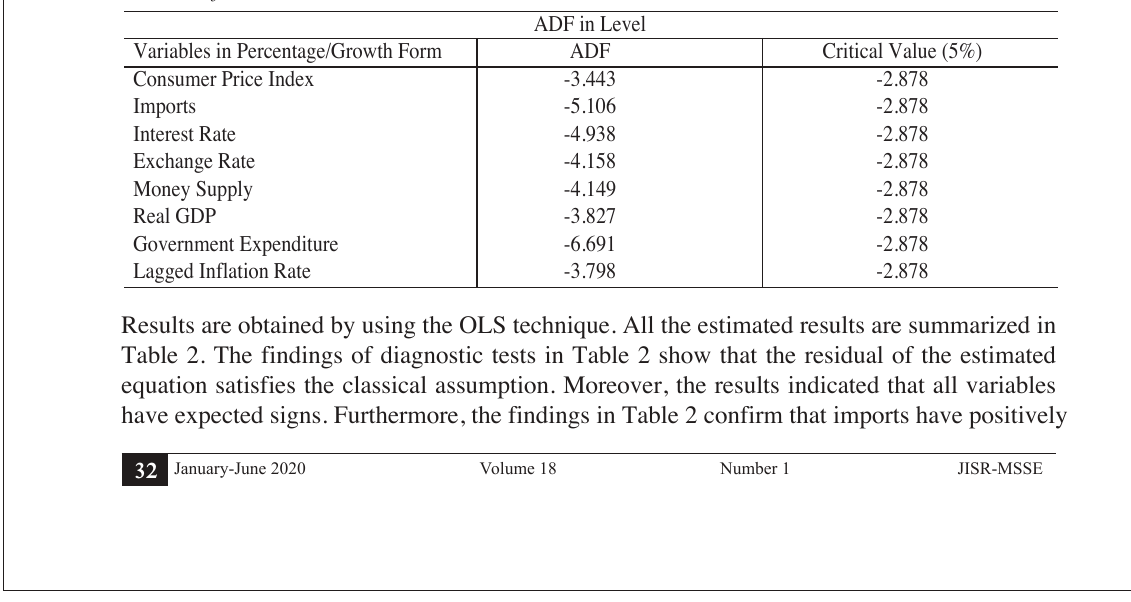
Table 1: Results of the ADF